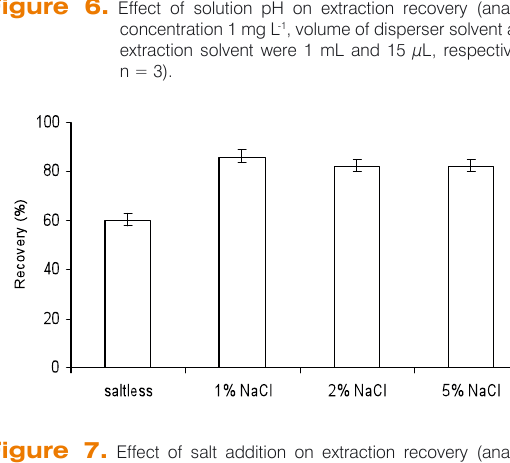
Figure 7. Effect of salt addition on extraction recovery (analyte concentration 0.1 mg L -1 , volume of disperser solvent and extraction solvent were 1 mL and 15 µL, respectively, pH = 3, n = 3).